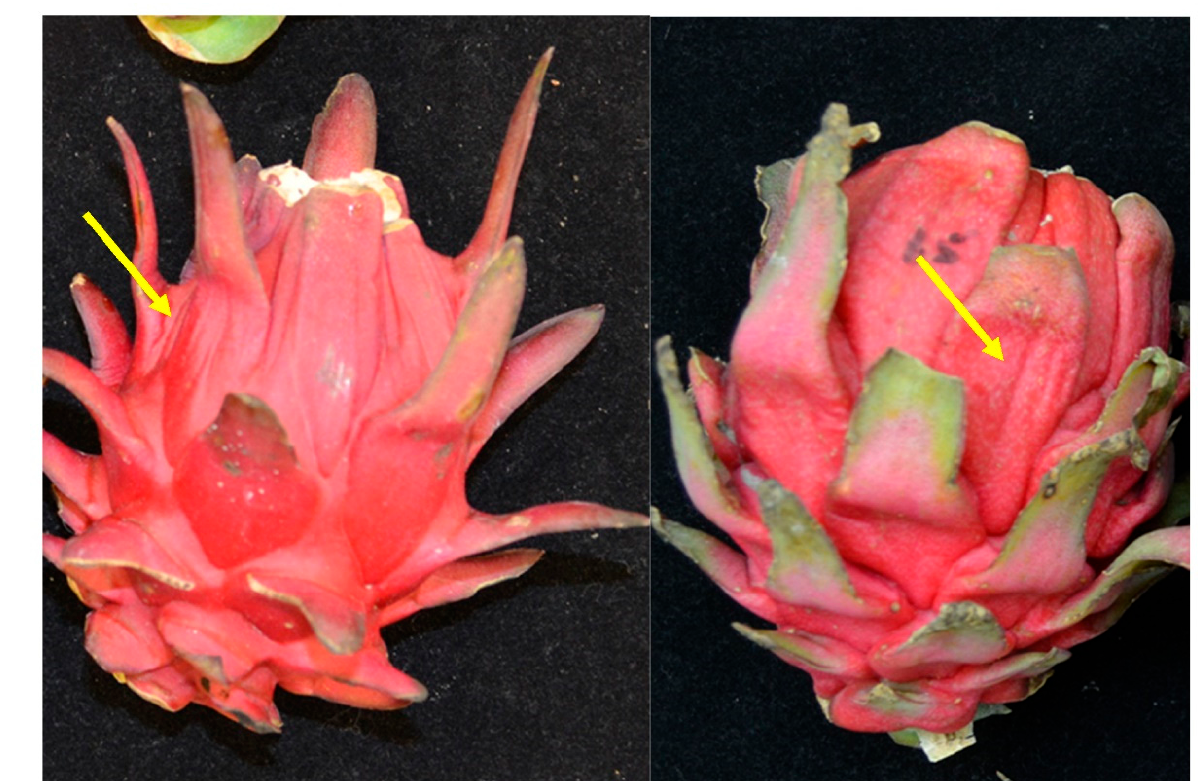
Table 1. Weight loss (%), shriveling (% surface area), anthracnose fruit rot (% surface area) and overall acceptability ratings (scale 1–5) for whole, coated and uncoated pitaya fruit during 20 days storage at 7 °C. Storage (d) Coating Weight Loss (%) z Shriveling (%) Anthracnose Fruit Rot (%)